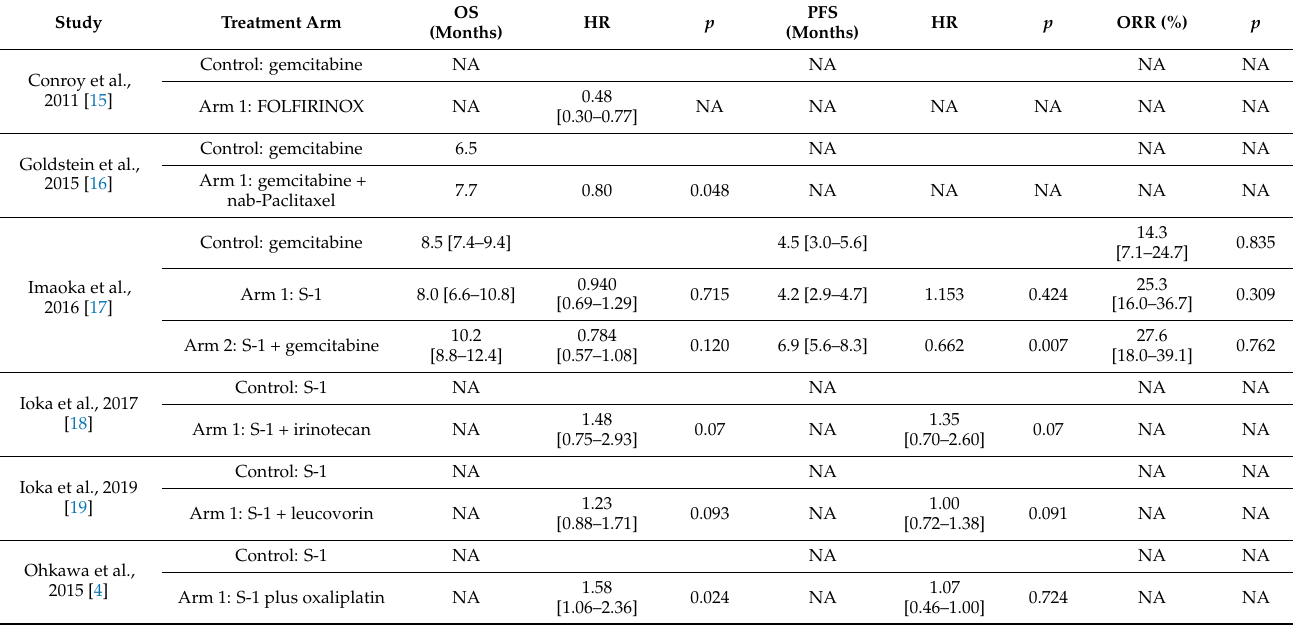
Table 3. Subgroup analysis of elderly patient outcomes including OS, PFS, and ORR along with 95% confidence intervals where